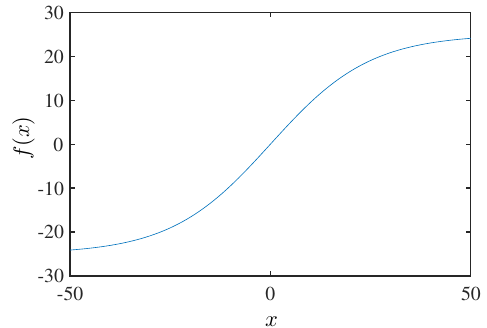
Figure 25. Input-output relationship for each f i